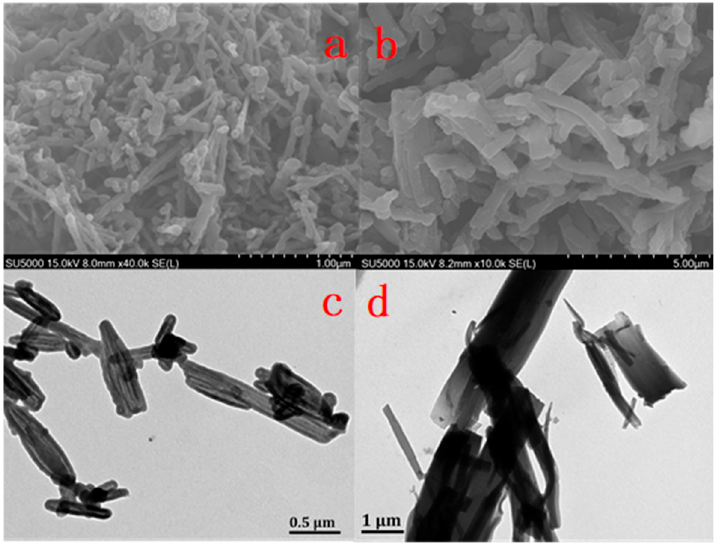
Figure 7. SEM images for ( a ) CP − shu − 1 and ( b ) CP − shu − 2, respectively. TEM images for ( c ) CPshu ‐ 1 and ( d ) CP − shu − 2.